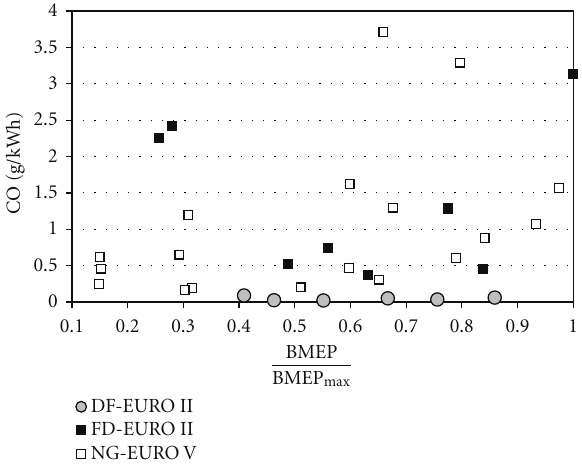
Figure 4: Tested points in FD, DF and full NG on the normalized engine map of the two engines.